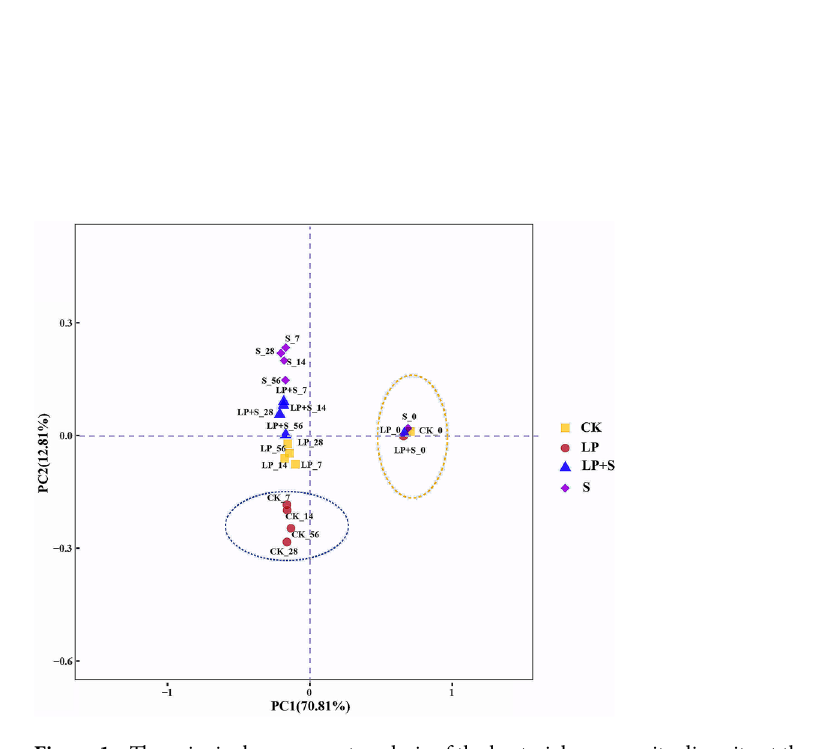
Figure 1. The principal component analysis of the bacterial community diversity at the genus level. CK, control; LP, Lactobacillus plantarum ; S, sucrose; LP + S, the addition of both sucrose and Lactobacillus plantarum